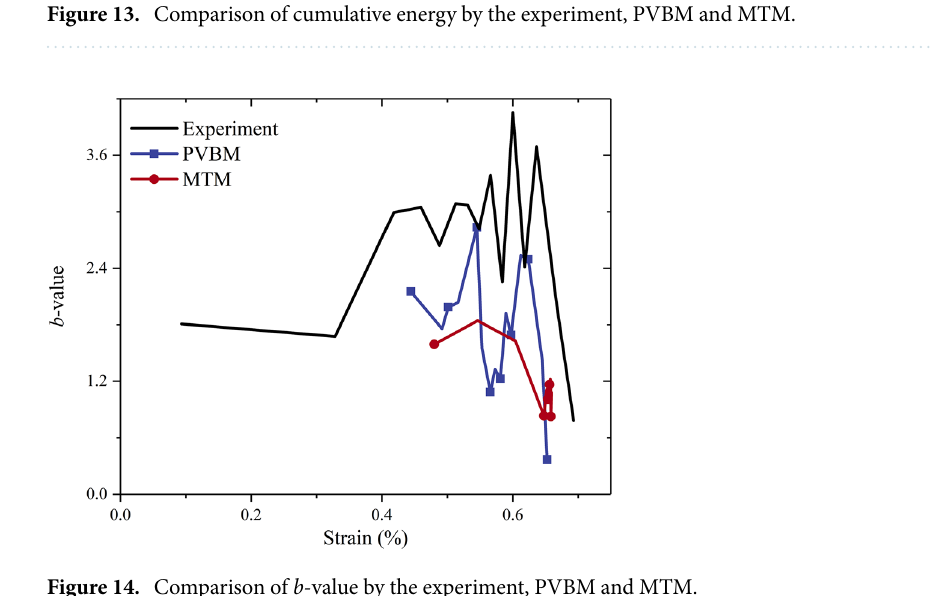
Figure 14. Comparison of b -value by the experiment, PVBM and